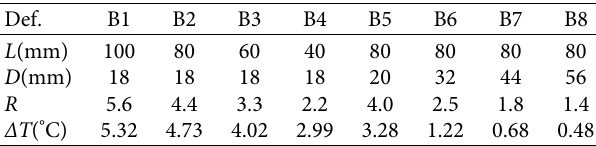
Table 1: Growth rate of temperature difference.